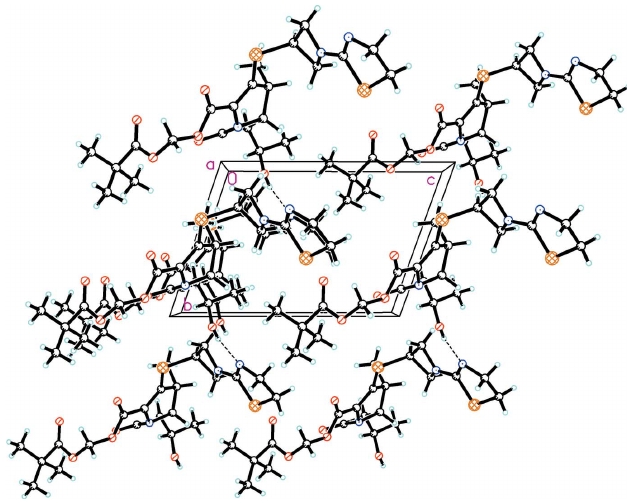
Figure 2 The crystal packing viewed along the crystallographic a axis showing the O—H (cid:2)(cid:2)(cid:2) N hydrogen bonds (Table 1) as dashed lines.